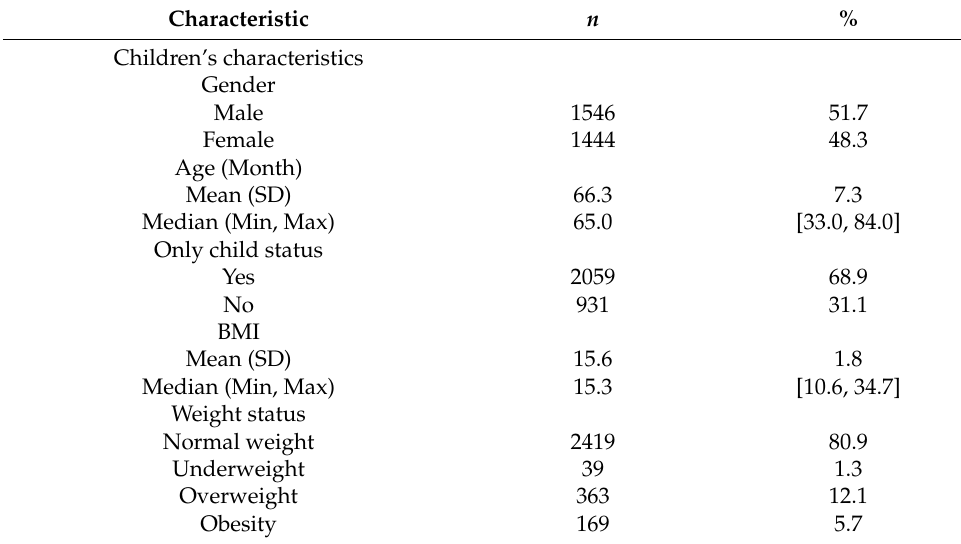
Table 1. Characteristics of the preschoolers and parents: n =